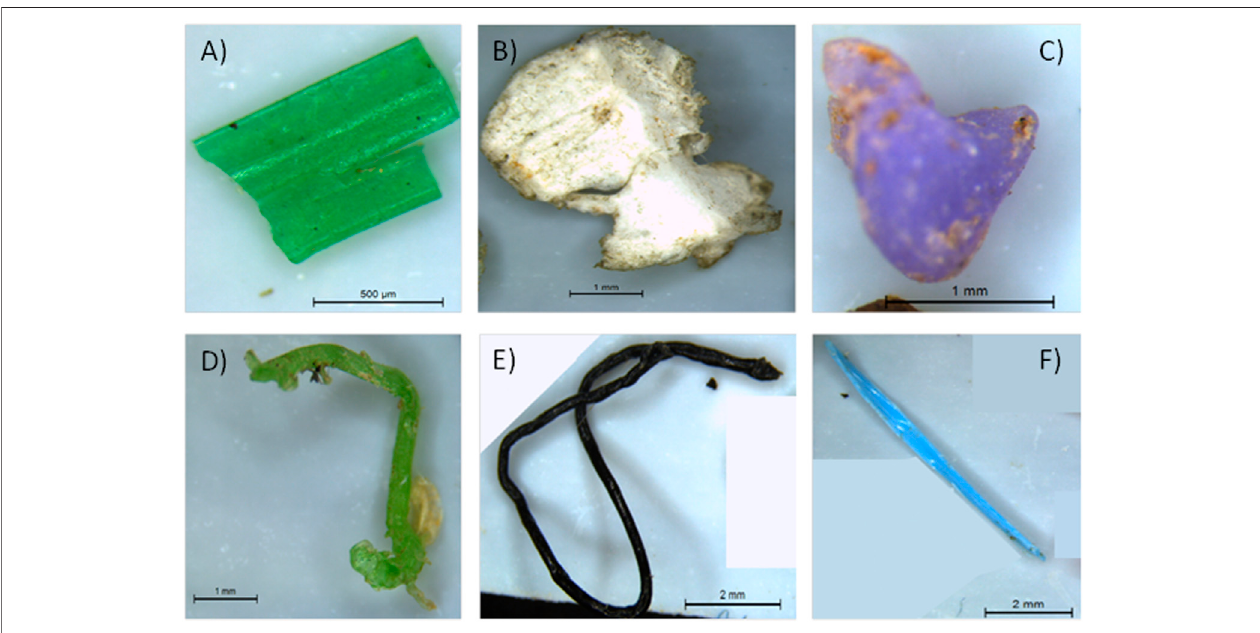
FIGURE 1 | Plastics of different shapes and colors collected along the Lebanese coast (A) Green (B) White and (C) purple fragments (D) green (E) black and (F) blue fi laments.